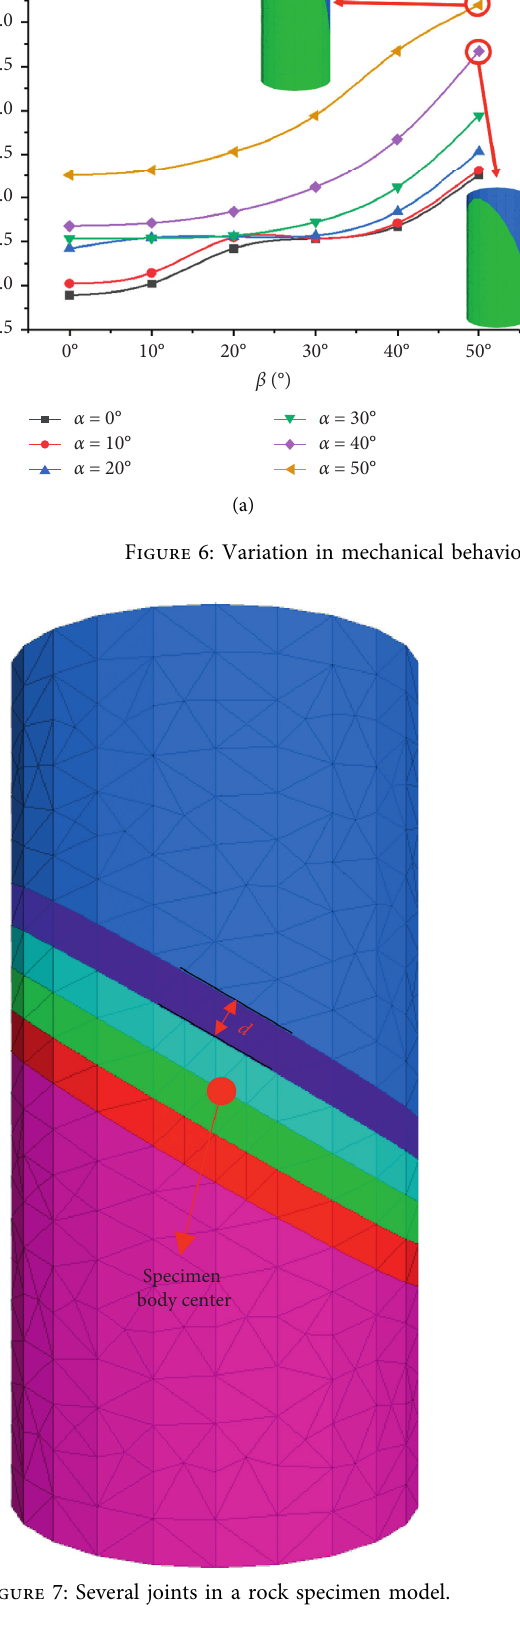
Figure 7: Several joints in a rock specimen